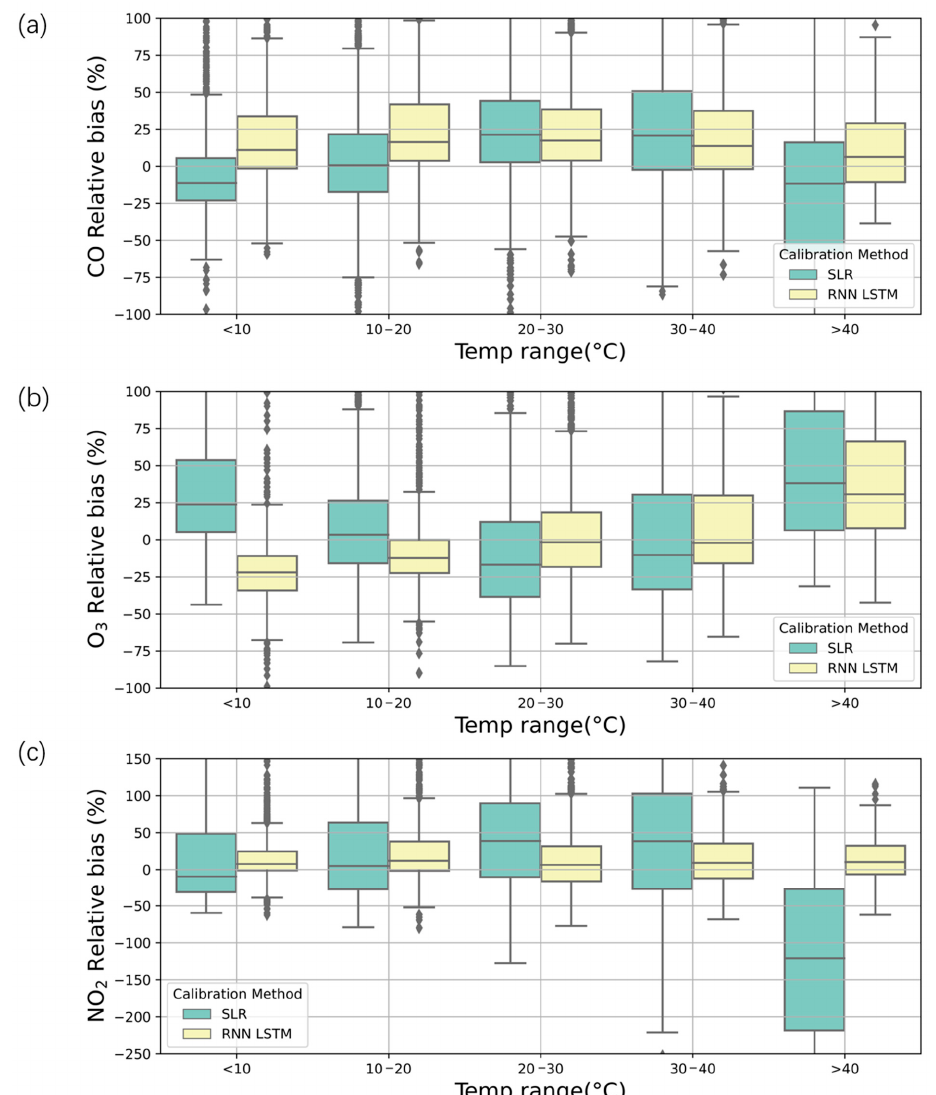
Figure 6. Comparison of the relative biases between the calibrated sensors and MEE at different temperature ranges. ( a ) CO, ( b ) O 3 , and ( c ) NO 2 . Humidity affects the reaction activities of different gas species [54]. CO is an inert gas, and thus, its relative biases showed no trend with increasing RH for either the SLR or LSTM models. O 3 showed a decreasing trend of relative biases, and NO 2 showed an in- creasing trend for the SLR method. In detail, the relative biases were less than 5% for all the RH conditions (Figure 7a). For O 3 , the relative biases decreased from 25% to 0% for RHs of <20% and 20–40%, while they increased to − 25% for RH conditions >40% using the